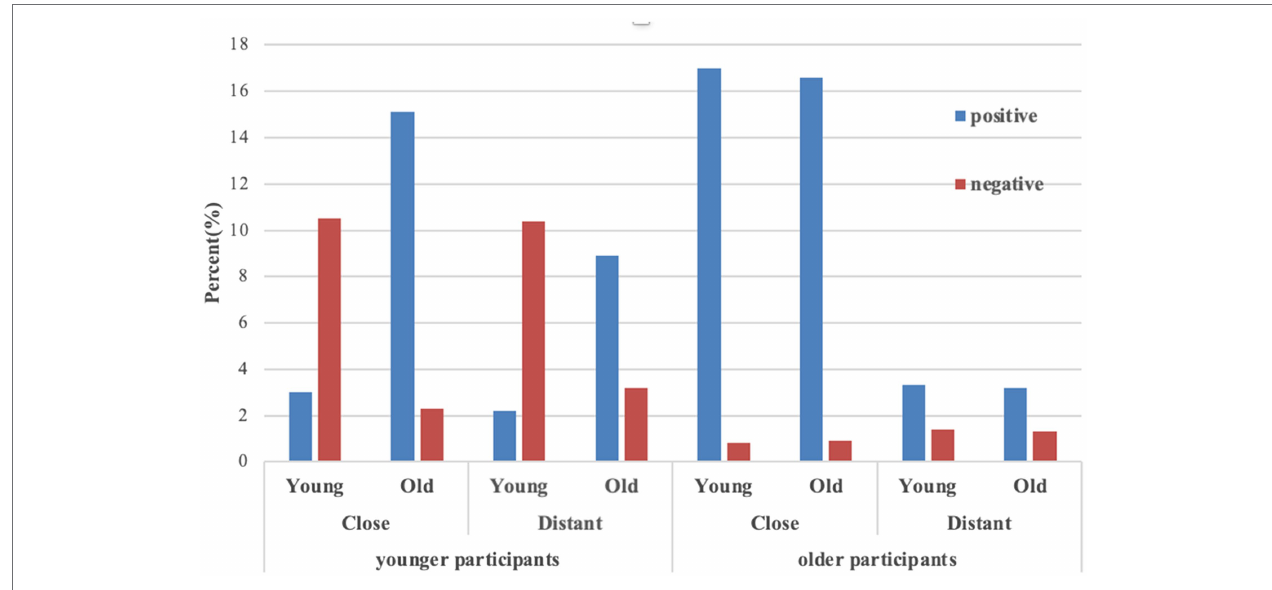
FIGURE 3 | Frequency of the valence of the smiling emoji.